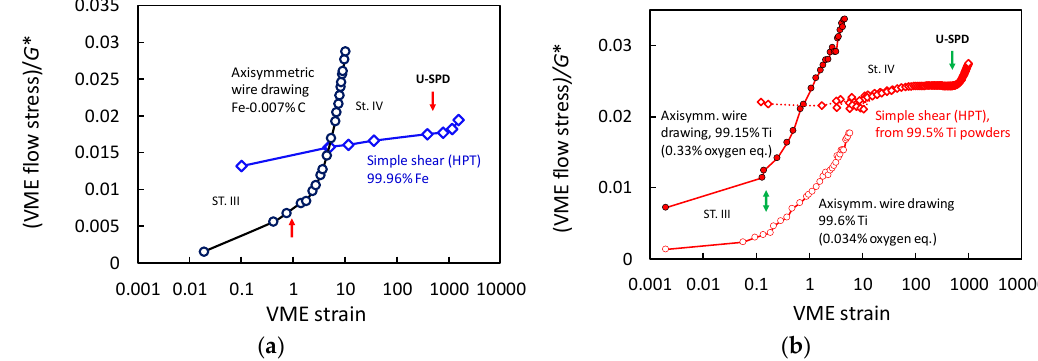
Figure 10. Stress–strain of ( a ) Fe and ( b ) Ti deformed by axisymmetric drawing (Fe-0.007%C, Langford and Cohen [58], 99.15% and 99.6% Ti, Biswas [65], UTS from tensile tests) and by simple shear (HPT, 99.96% Fe and 99.5% Ti, Edalati [56,66], HV/3). Notice the logarithmic scale of the abscissa. The difference in the flow stresses at small/moderate strains may be due to differences in the friction-like flow stress fraction (chemical composition, interstitial content in particular) and initial grain size of the materials, the different testing method for flow stress determination, and the unaccounted compressive deformation of the HPT disk at the beginning of the HPT shear test.